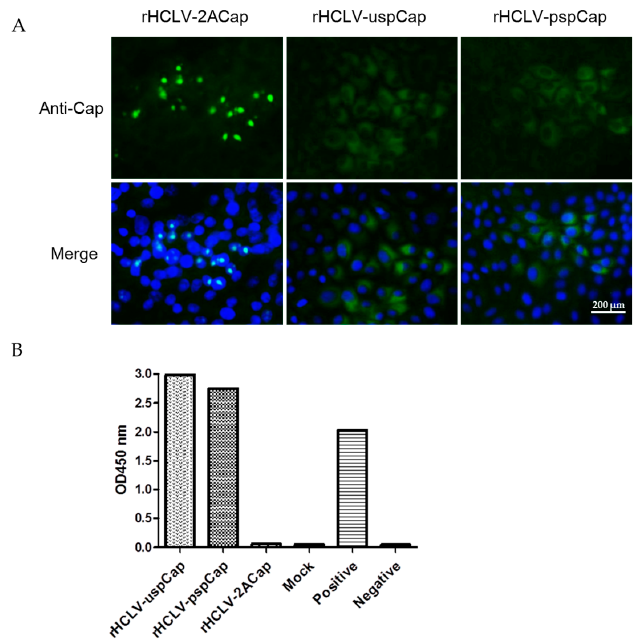
Figure 3. Analysis of the expression of Cap gene in the recombinant viruses by IFA ( A ) and by antigen-capture ELISA ( B ). ( A ) SK6 cells were mock treated or infected with the rescued viruses at an MOI of 0.1, respectively. At 48 h post-infection, the cells were processed by indirect immunofluorescence assay using an anti-Cap monoclonal antibody and the nuclei were strained with the 4 ′ ,6-diamidino- 2-phenylindole (DAPI). The pictures were taken under a fluorescence microscope (TE2000-U, Nikon). The independent experiments were repeated three times. Bar is 200 µm; ( B ) The PCV2 Cap protein in the supernatants from the cells infected with the recombinant viruses or DMEM (Mock control) was tested by an antigen-capture ELISA (Ingenasa).